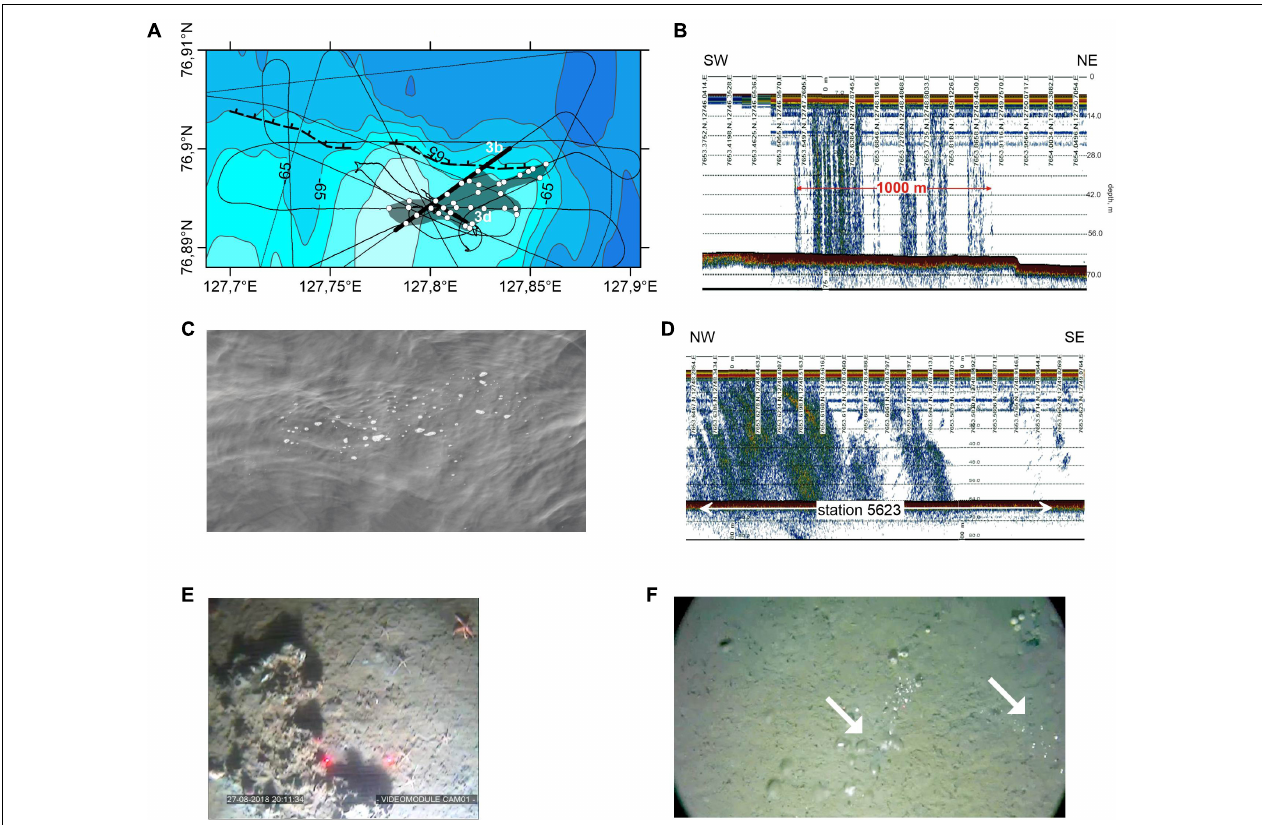
FIGURE 2 | (A) Bathymetric map of the Oden site and location of the bathymetric and hydroacoustic tracks (thin lines). Thick lines mark the locations of the echogram fragments shown in (B,D) , gray area indicates the seep field where filled white circles mark the centers of the gas flares, dashed black line with half ticks marks the scarp. Contour interval is 1 m; (C) gas bubbles in the sea surface, dimension is 2.5 m; (E) seafloor bottom photographs showing the carbonate crusts (the distance between the red laser points is 20 cm), and (F) gas bubbles marked by